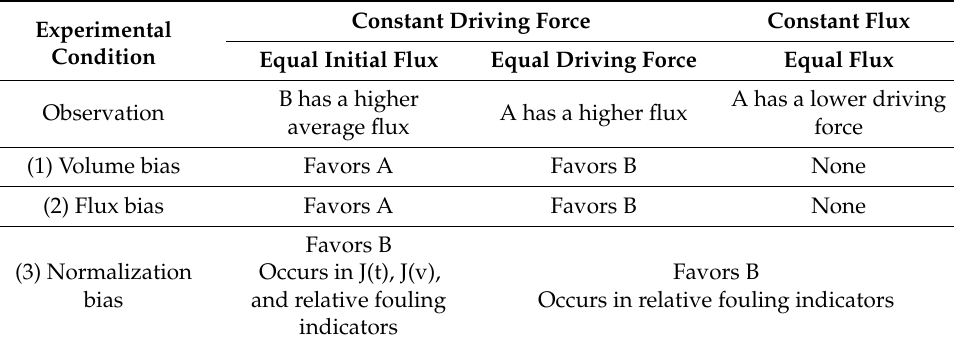
Table 1. Summary of the discussed causes for biases in different experiments. In the example given in this paper, A refers to the more-permeable membrane, and B refers to the less-permeable membrane. More generally, A can refer to the system or situation that more efficiently relates driving force to